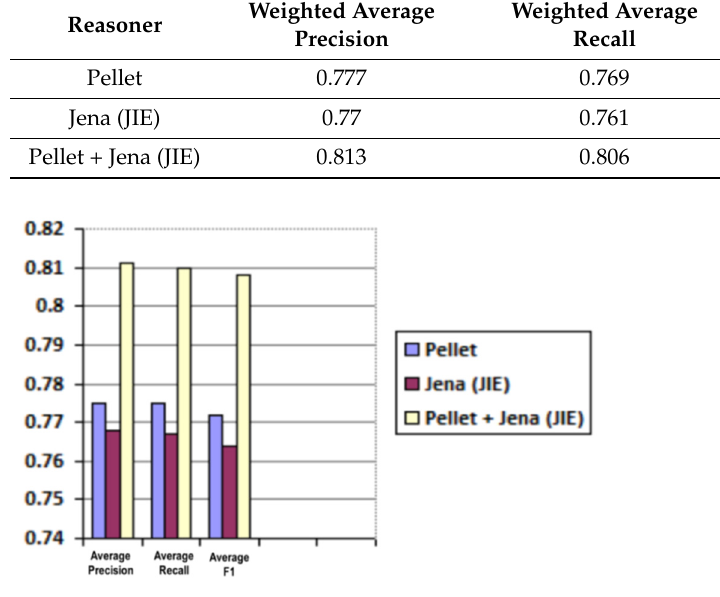
Table 4. Predicted roles evaluation (weighted average values for precision, recall and F1). Table 3. Predicted roles evaluation (average values for precision, recall and F1).